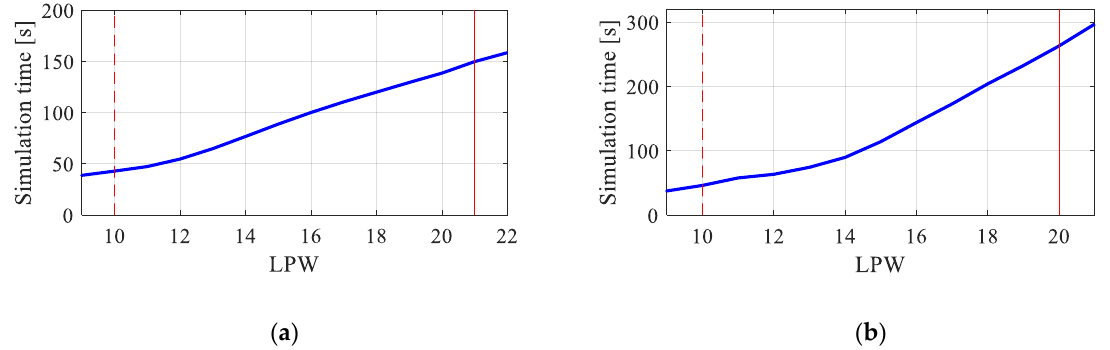
Figure 6. Benchmark monopole antennas: simulation time versus fidelity level: ( a ) Antenna I, ( b ) Antenna II. Discretization density parameters (lines-per-wavelength, LPW) for the minimum (- - -) and the maximum ( — ) considered level of fidelity (vertical lines).